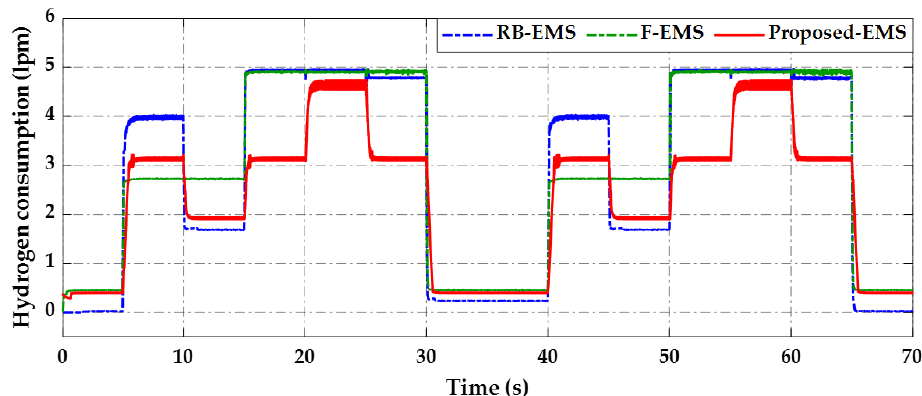
Figure 22. The comparison of hydrogen consumption of PEMFC stack.